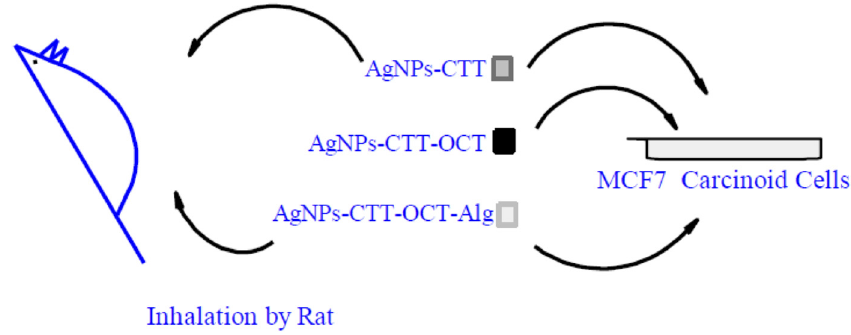
Figure 8: Schematic representation of the di ff erent types of AgNPs applied in in vitro and in vivo